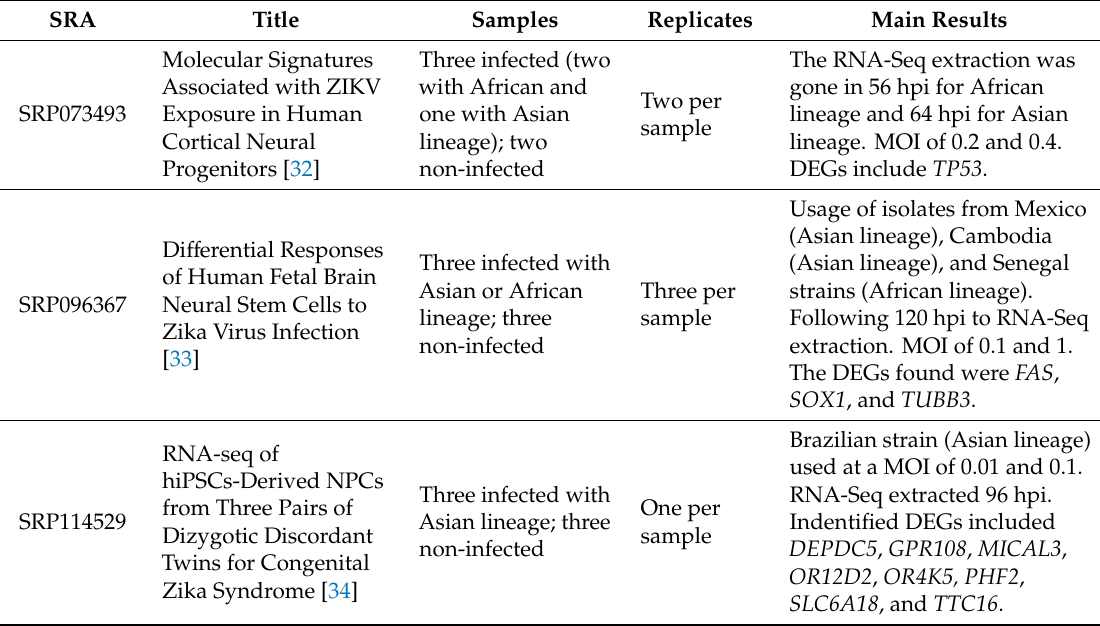
Table 1. Detailed information regarding the three selected studies that matched the study criteria. DEGs: di ff erentially expressed genes, hiPSCs (human-induced pluripotent stem cells), MOI (multiplicity